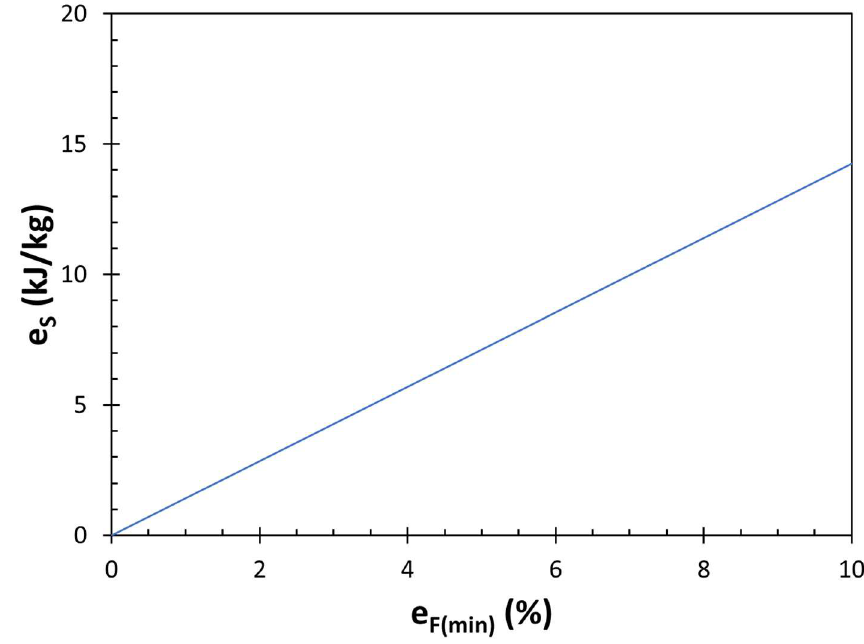
Figure 2. Specific energy absorption as a function of elongation requirement. Based on Equations (5) and (6), it can be shown that weight of the part is directly correlated with the ductility of the casting for the part to absorb the same energy during the